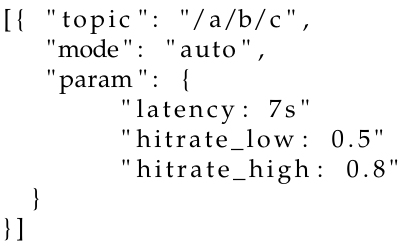
Figure 8. Activation of the QoS controller in hitrate-constrained mode.